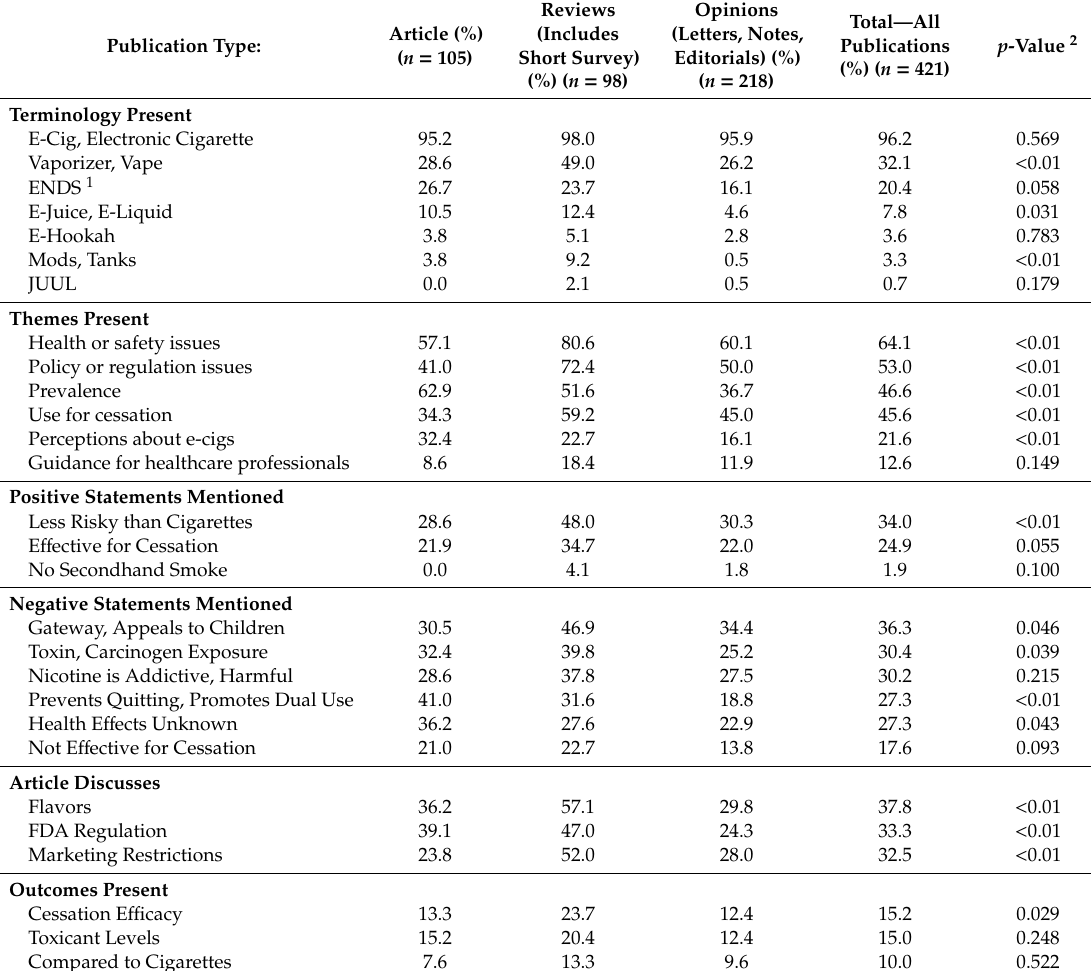
Table 1. Prevalence and trends of electronic nicotine delivery system publications in core clinical journals using specific terms, themes, belief statements, and